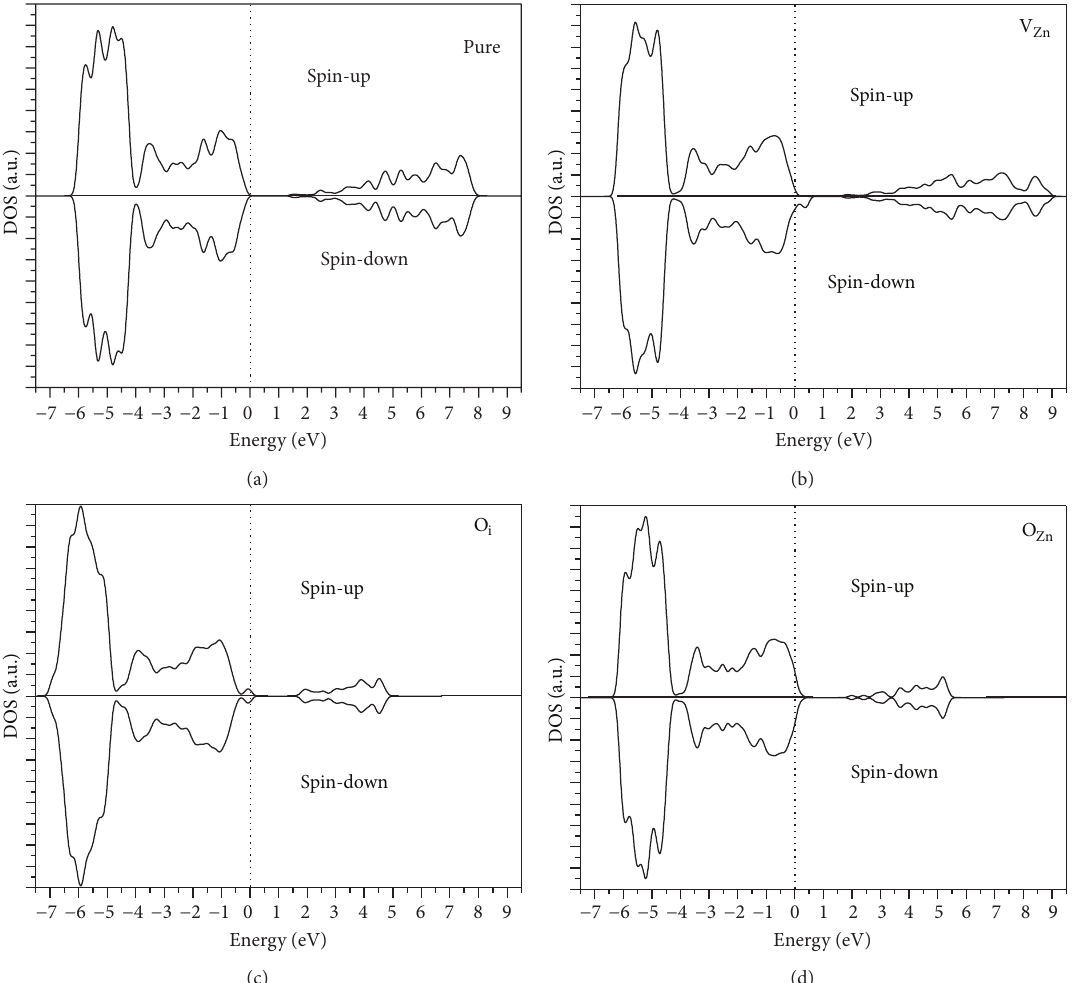
Figure 6: Calculated DOSs for ZnO nanorod. The Fermi level is set to zero on the energy scale, which will be adopted below unless otherwise